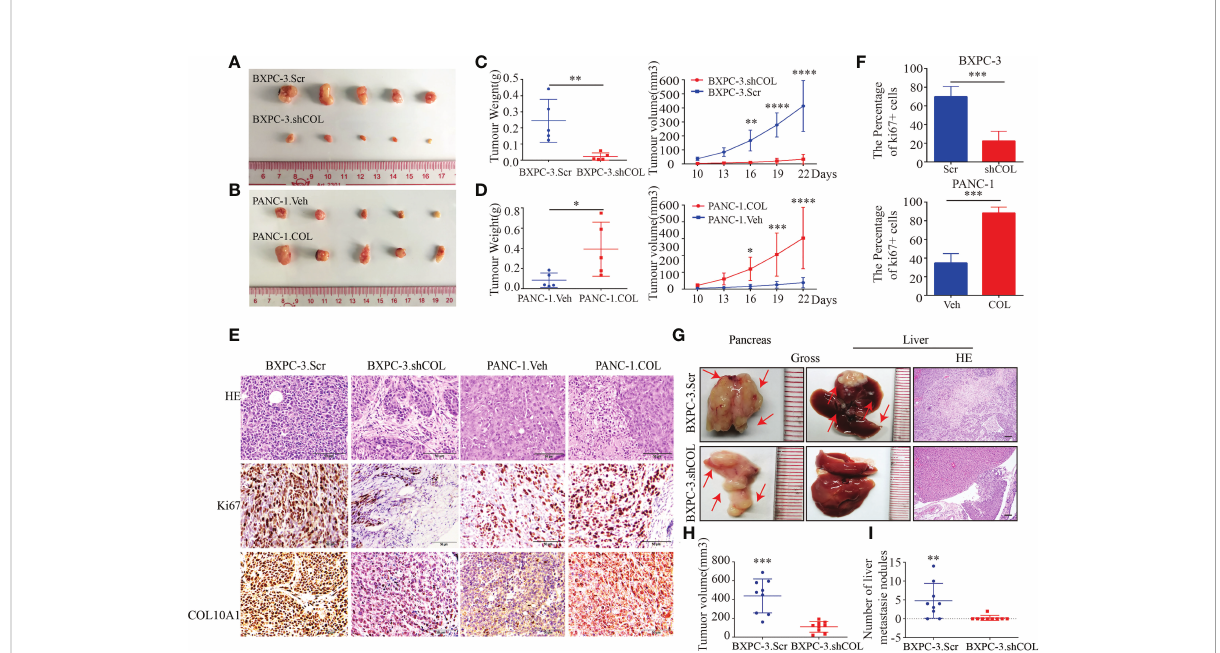
FIGURE 3 COL10A1 promotes PDAC proliferation and migration in vivo . (A, B) Images of gross PDAC subcutaneous xenograft tumor models formed by the indicated cell lines. (C, D) tumor volume and weight analyses for the subcutaneous xenograft tumor. Means ± SD are provided (n=5). (E) Representative images of H&E staining and ki67, COL10A1 IHC staining of tumors from subcutaneous xenograft tumor models. Scale bars, 50 m m. (F) The percentage of positively stained Ki-67 cells in subcutaneous tumors. (G) Representative images of gross and H&E staining in PDAC orthotopic models formed by the indicated cell lines. Means ± SD are provided (n=9). Scale bars, 50 m m. (H) tumor volume analyses of the PDAC primary tumors in PDAC orthotopic models. (I) The metastatic nodules in the livers per group were counted. * P < 0.05, ** P < 0.01, *** P < 0.001, **** P <